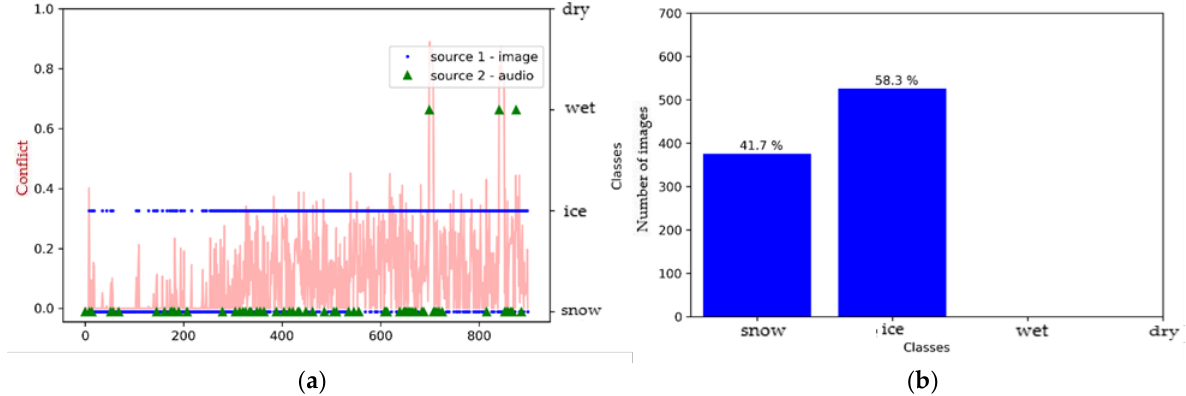
Figure 11. Environment #2. ( a ) Classification of sources with SqueezeNet (video) and M5 (audio) prior to fusion, together with conflict analysis; ( b ) histogram prior to image fusion.